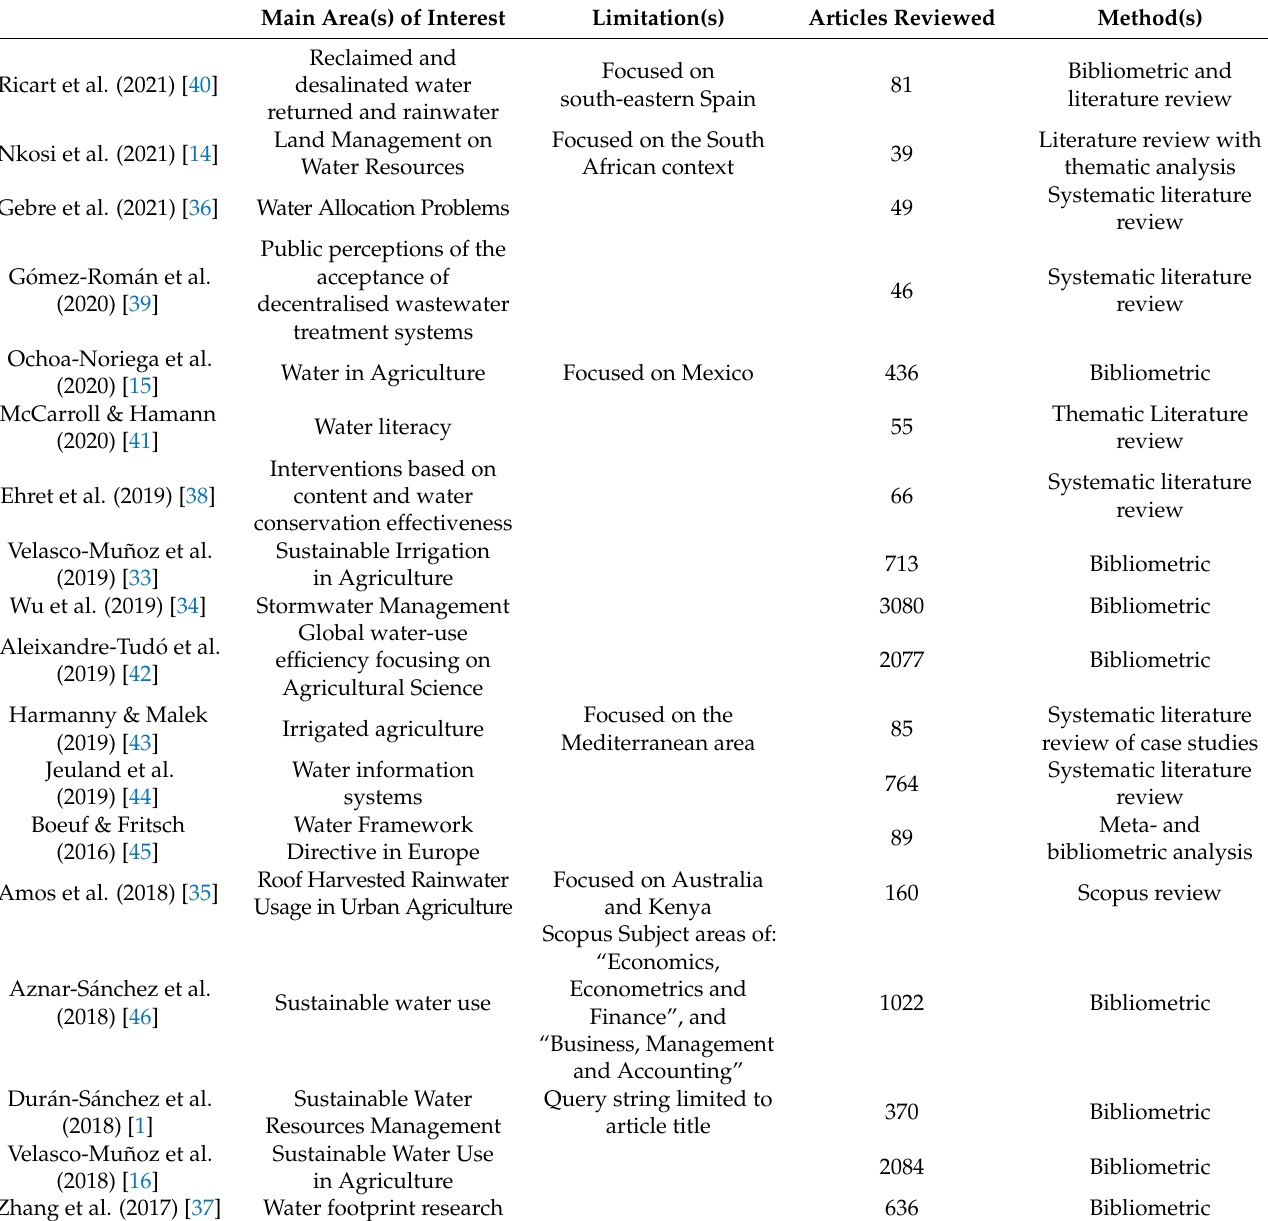
Table 1. Overview of systematic reviews on water